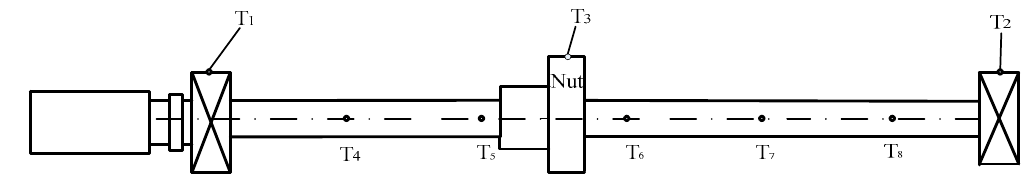
Figure 2. Distribution of measurement points.